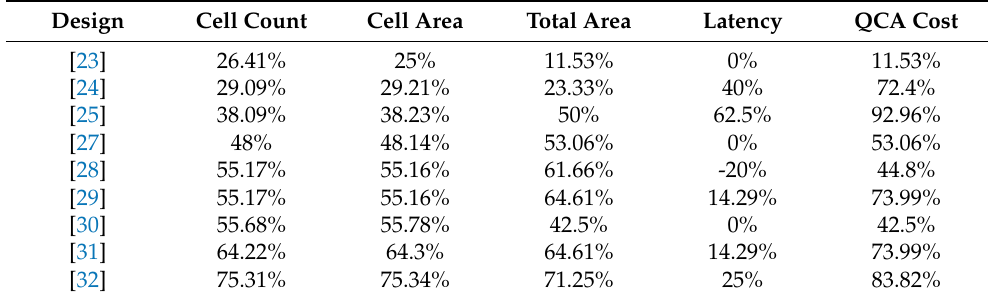
Table 3. Performance Improvement of Proposed Memory Cell Compared to Existing Designs.